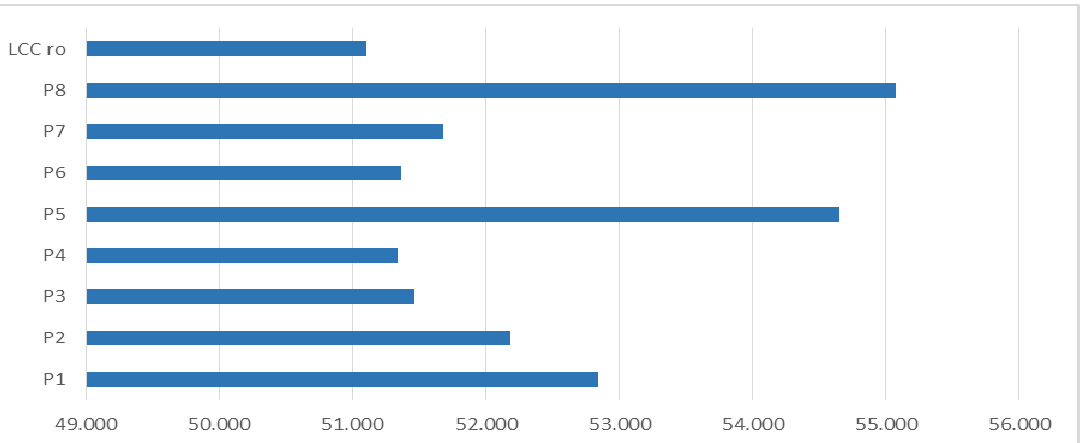
Figure 9. LCC at regional level for the minimum scenario (bln.euro). Energies 2018 , 6 , x FOR PEER REVIEW